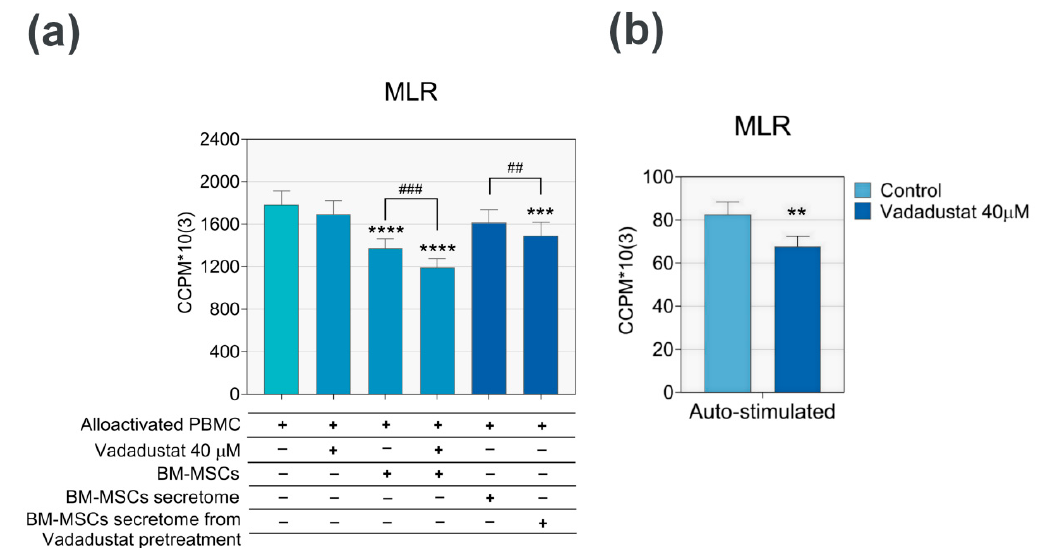
Figure 4. Mixed lymphocyte reaction (MLR) assay. The e ff ect of 40 µ M Vadadustat on the allo-